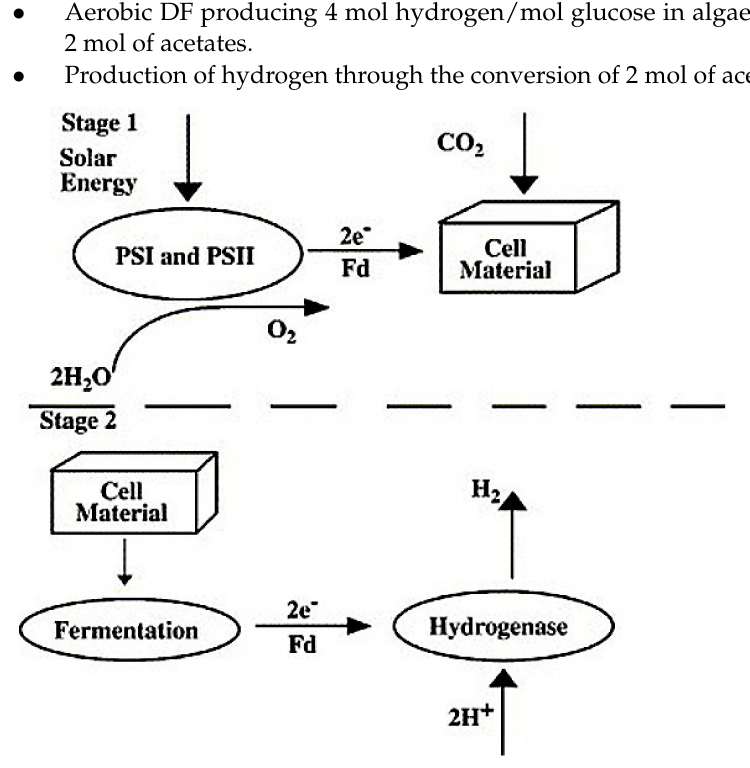
Figure 10. Production of hydrogen using an indirect bio-photolysis approach [83]. Reproduced with permission from Elsevier,